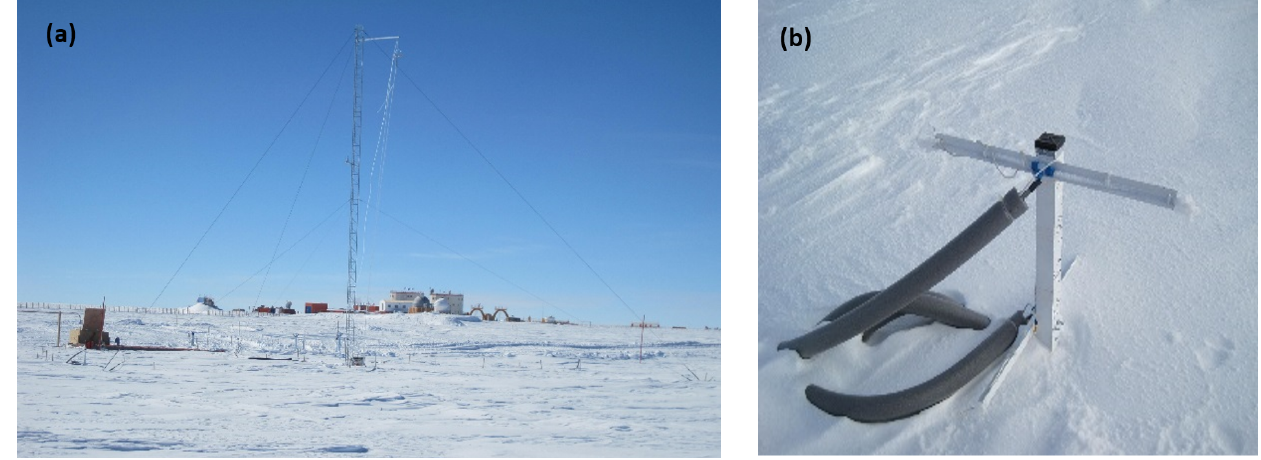
Figure 2. (a) Meteorological tower with the station infrastructure in the background. The wooden box to the left is the entry hatch to the underground laboratory. Air sampling inlets were located at 0.5, 2, and 10m above the surface on the tower. Two snowpack air sampling towers were located approximately 7m to the left and 10m to the right of the base of the meteorological tower. (b) One of the two snowpack air sampling manifolds (snow tower), with one pair of inlets right on the snow surface and one inlet pair at ∼ 30cm height. Four more equivalent sampling inlet pairs are below the snow surface at 30cm depth intervals extending to a maximum depth of 1.2m (see Fig. 1 in Van Dam et al., 2015, for a schematic of a similar installation at Summit,